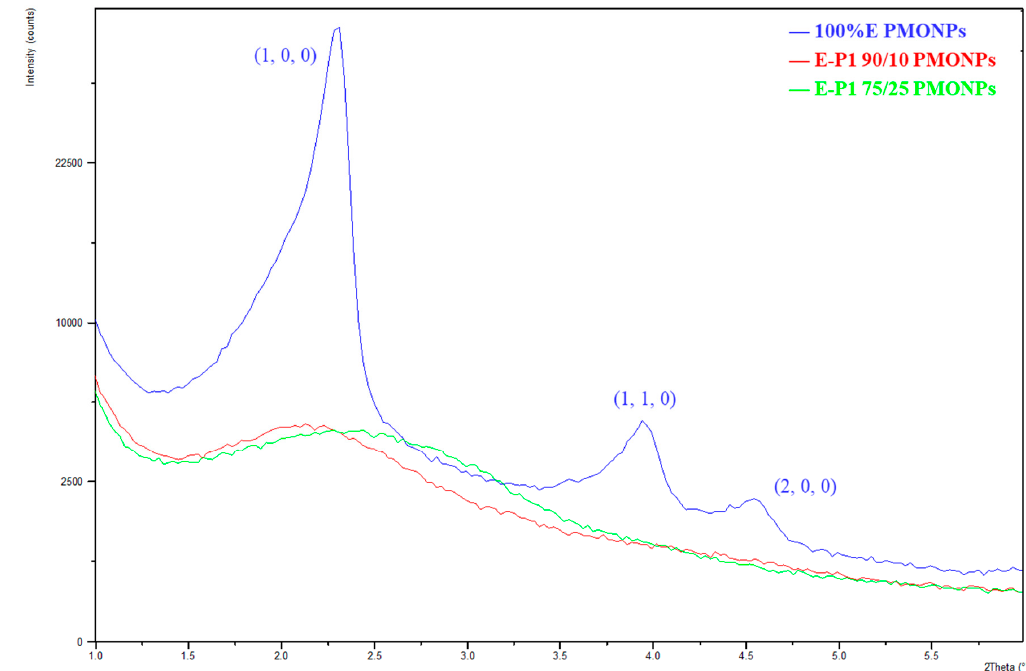
Figure 3. Small angle XRD diagram of E (blue line), E ‐ P1 90/10 (red line), E ‐ P1 75/25 (green line).